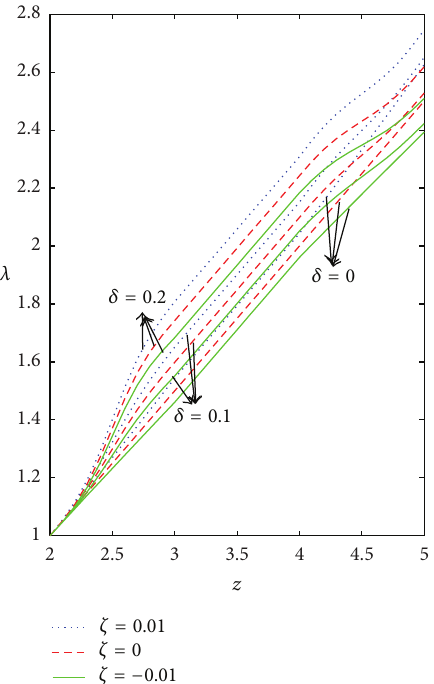
Figure 11: Axial variation of flow resistance ( 𝜆 ) for different values of 𝑘 taking 𝑛 = 0.8 , 𝜏 𝑦 = 0.1 , and 𝛿 = 0.2 .